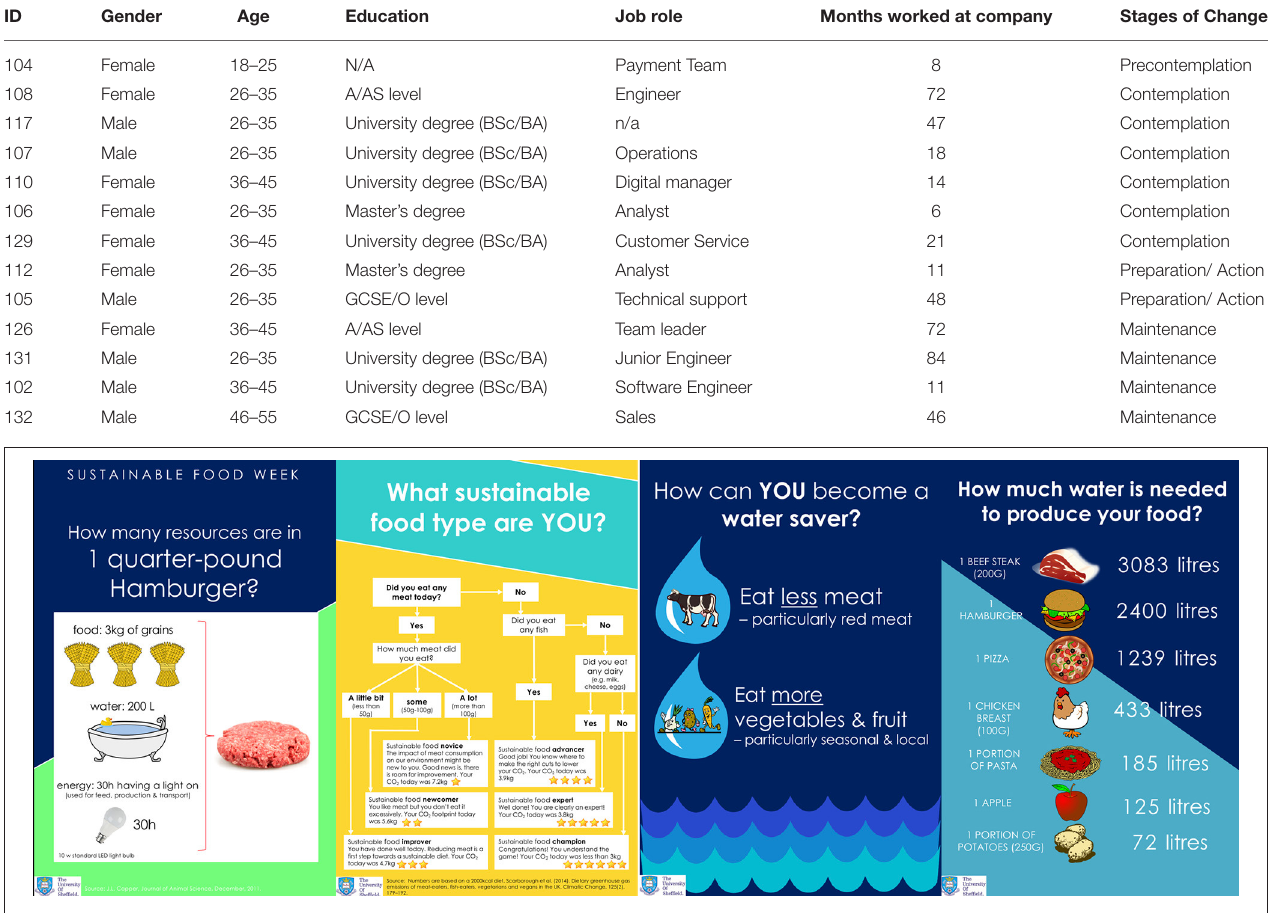
TABLE 1 | Sample information.